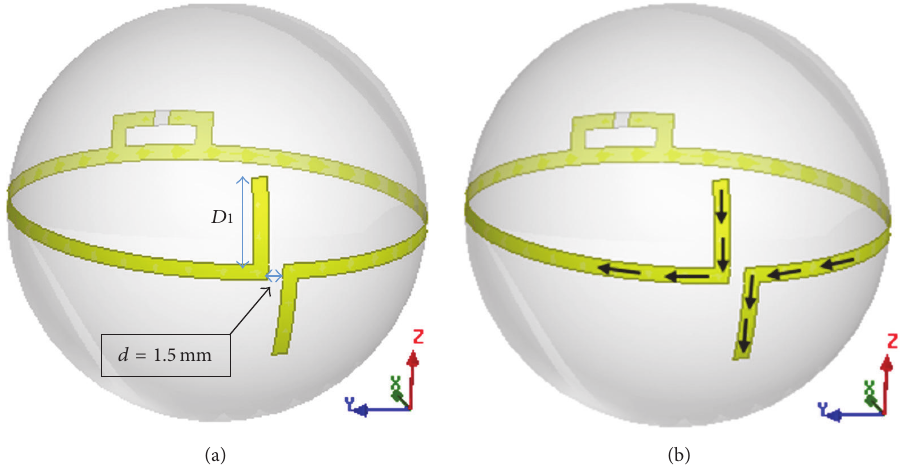
Figure 13: (a) Structure of the 3D spherical antenna with folded arms and (b) current direction along the folded arms.